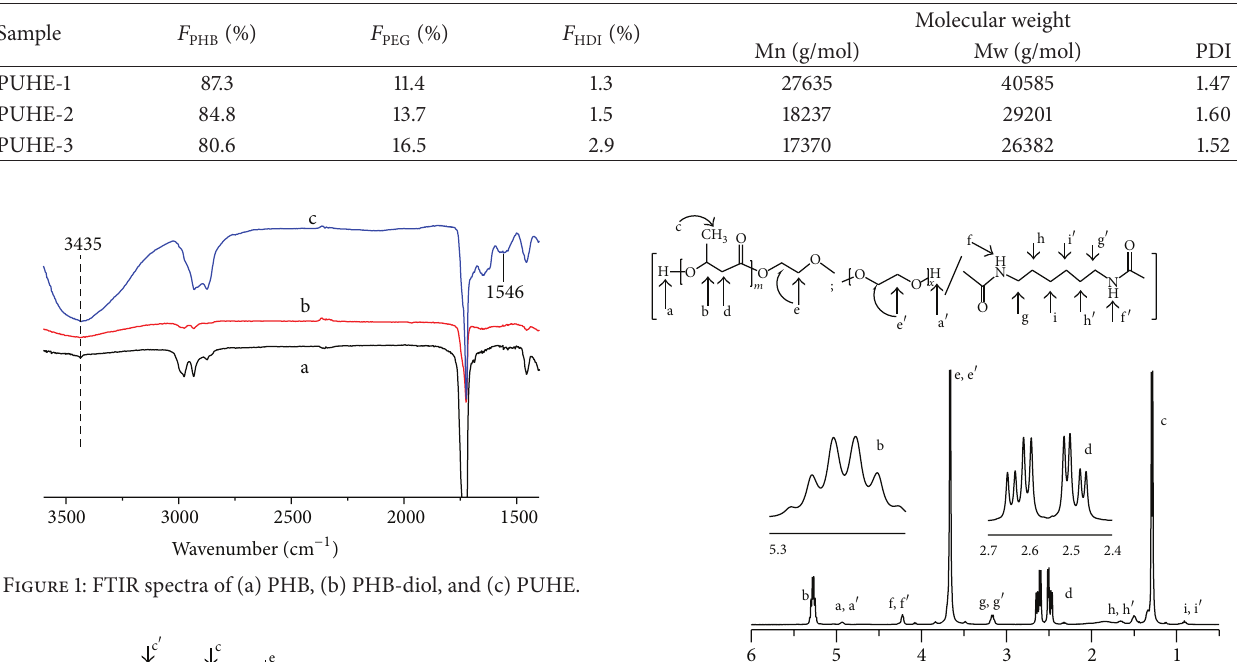
Table 2: Compositions and molecular weights of resulting PUHE copolymers.